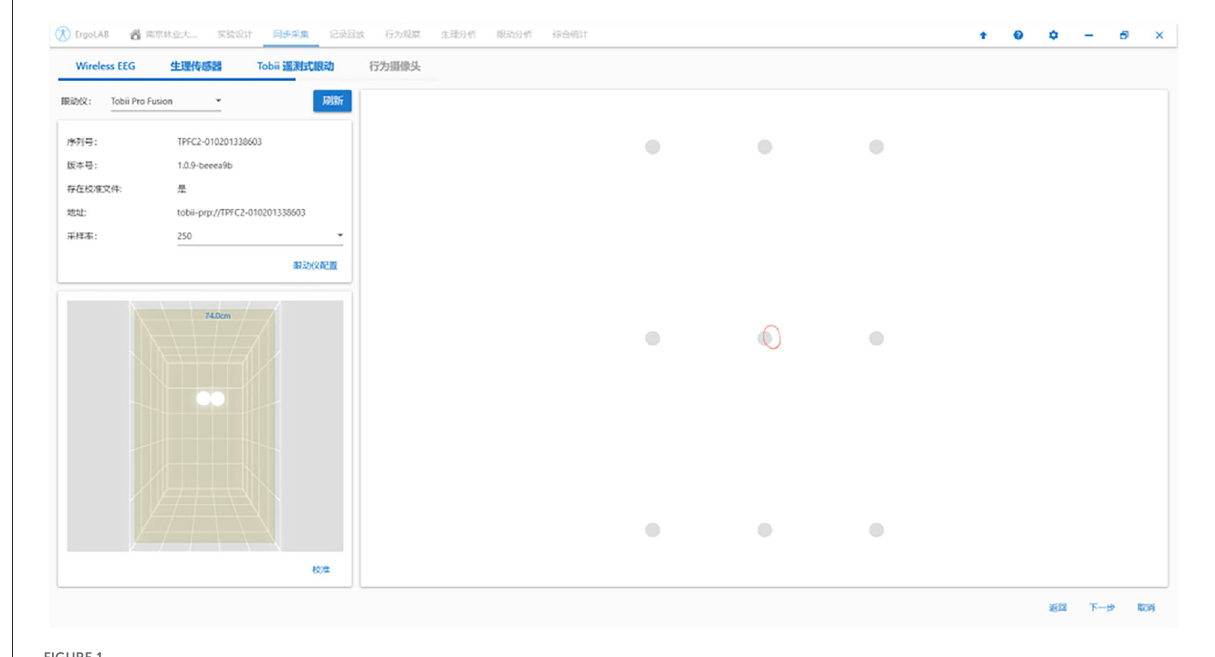
FIGURE1 Eye movement experiment calibration page.